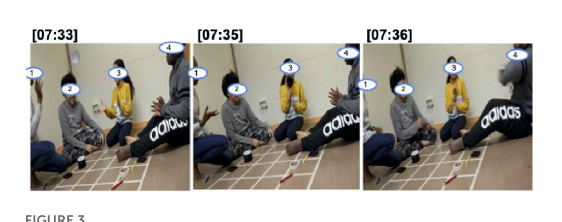
FIGURE2 Examples of private turns. Participant 1 is engaged in a solitary drawing activity not attended to by the other participants while player 2 is handling the round box also not attended to by other participants.